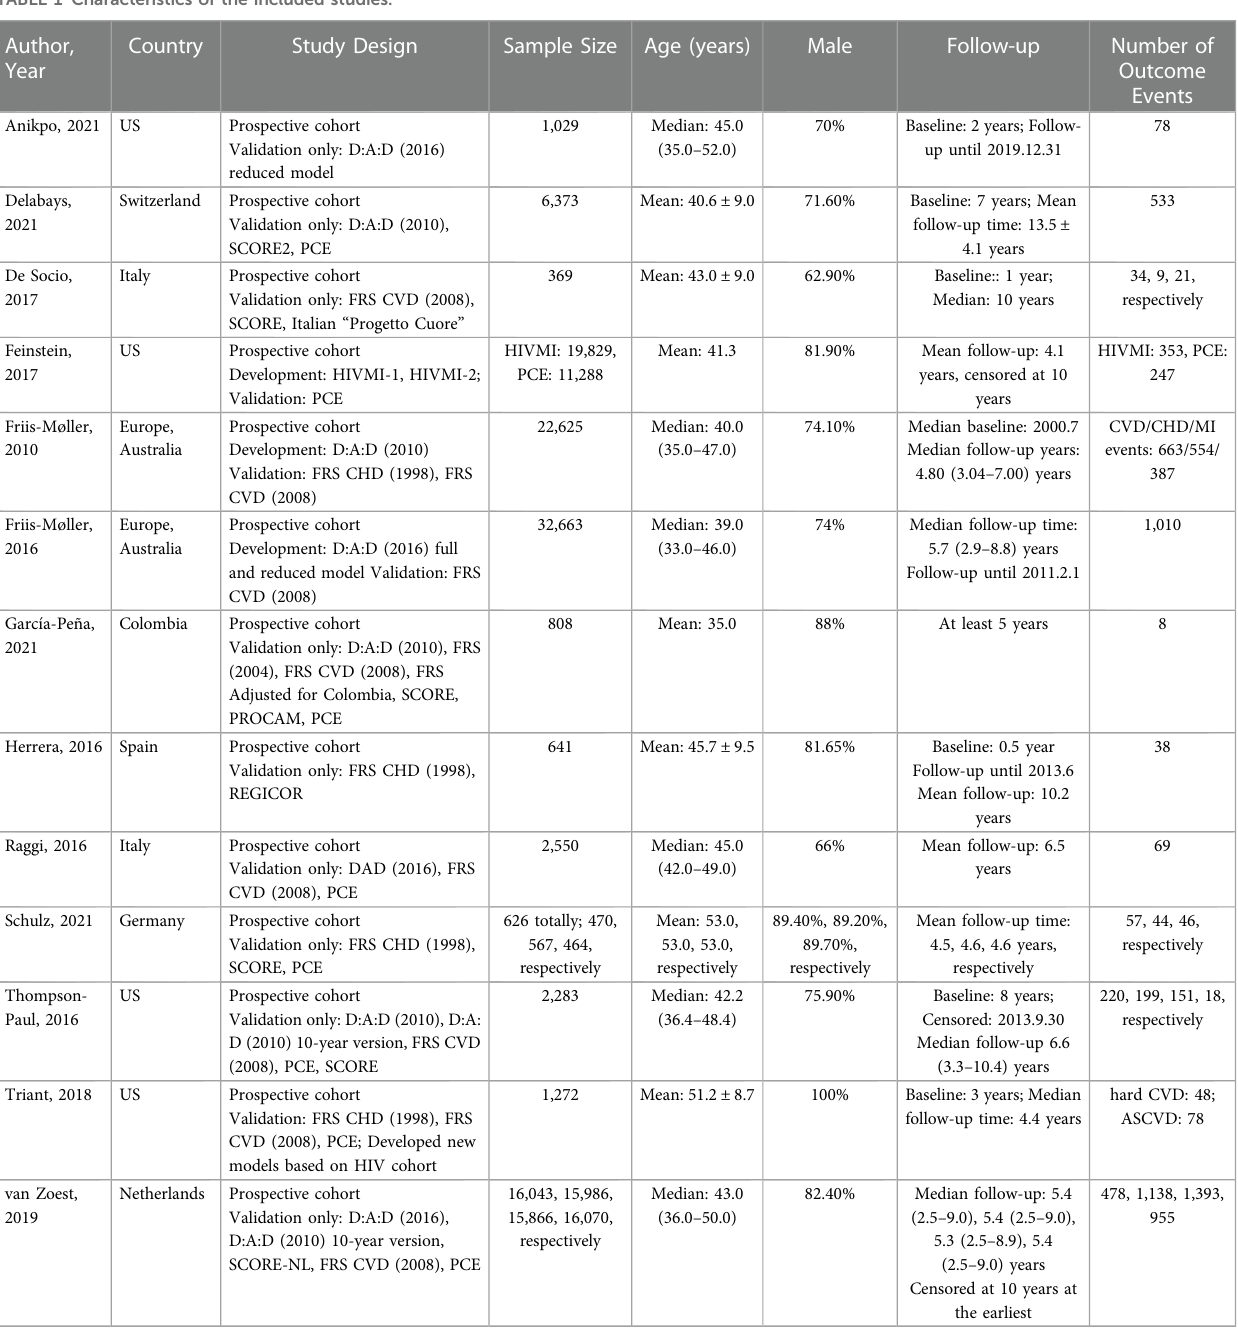
TABLE 1 Characteristics of the included